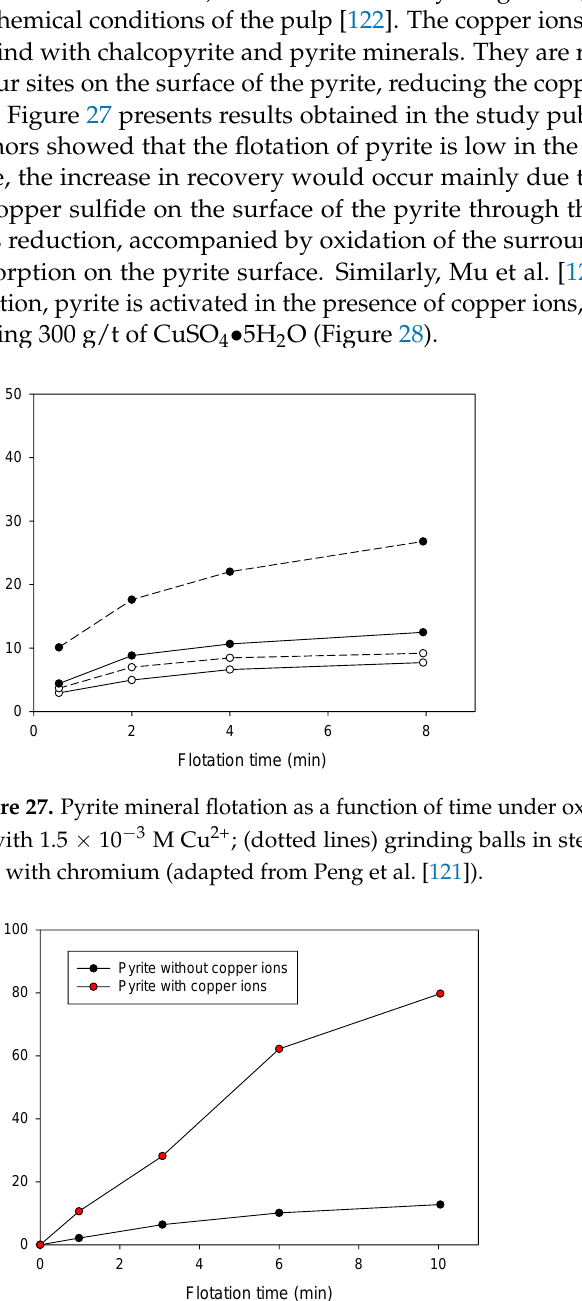
Figure 28. Recovery of pyrite in the absence and presence of 300 g/t CuSO 4 ·5H 2 O with PAX at pH 9.0 (conditions: 1.5 L flotation cell where H 2 SO 4 /NaOH was added to adjust the pH and airflow of 6 dm 3 /min) (adapted from Mu et al. [123]).